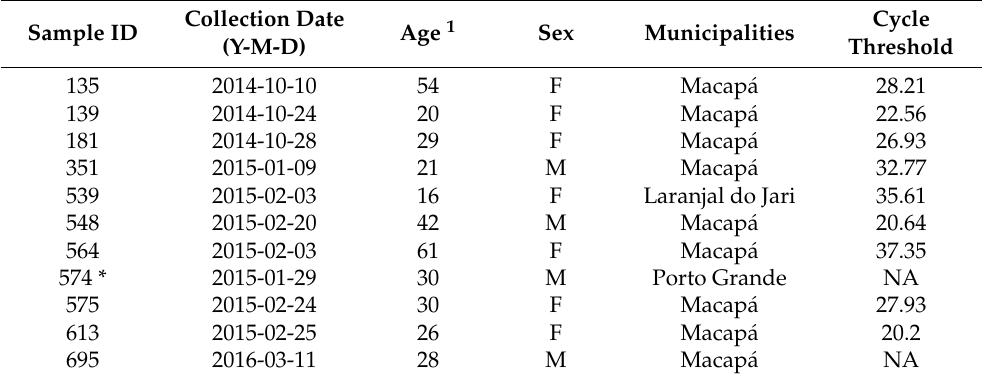
Table 1. Epidemiological data for the CHIKV